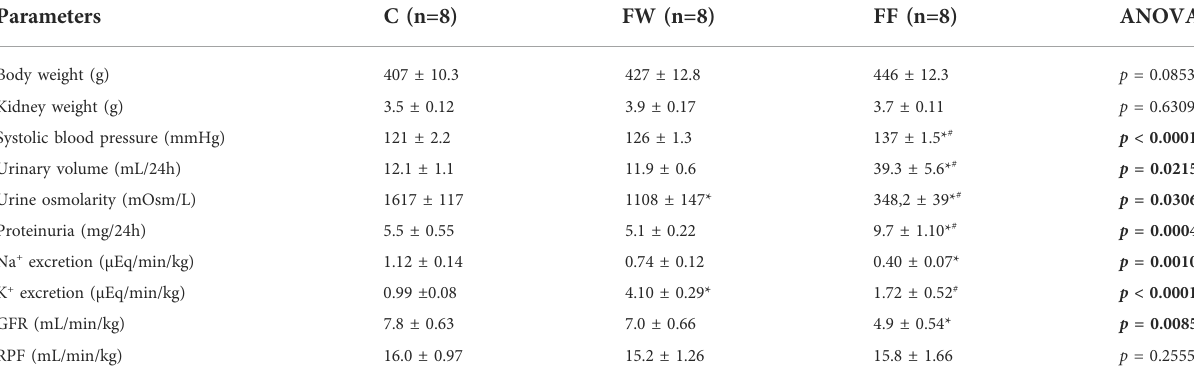
TABLE 1 Body weight, blood pressure and renal function parameters from the experimental groups.